Question: Give a one-sentence summary of this figure.
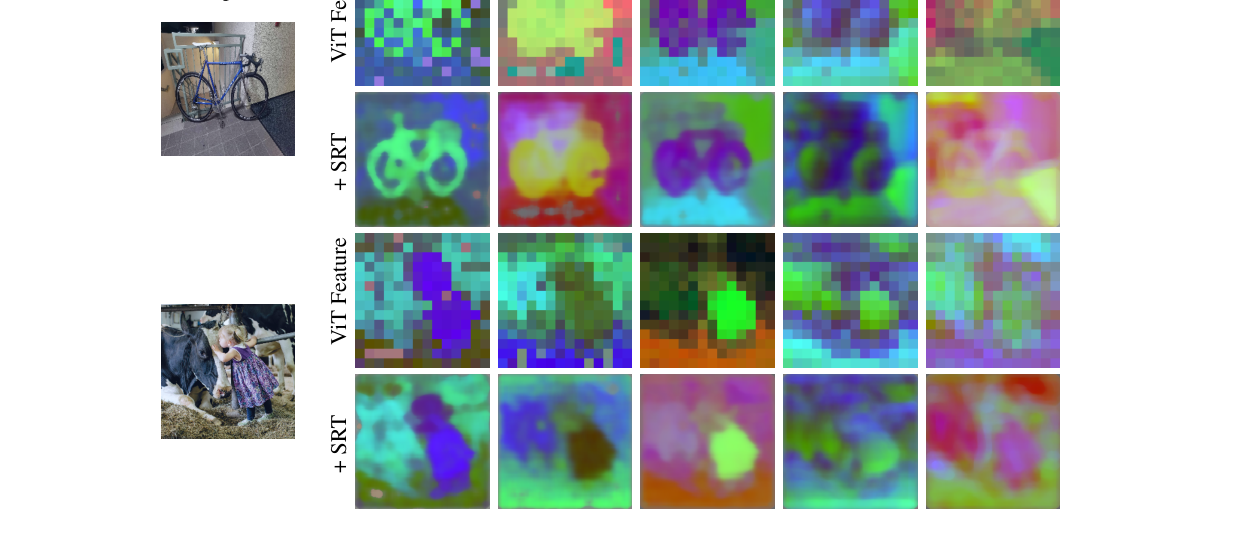
Answer: High-resolution ViT features computed by stochastic resonance. Stochastic Resonance enables enhancing tokenized ViT features during inference without the need for additional training or modifying ViT forward pass. Here we present enhanced features from different pre-trained ViT models, visualized via Principal Component Analysis: CLIP (Radford et al., 2021) captures major image components. Interestingly, although Supervised (Dosovitskiy et al., 2020) and DINO (Caron et al., 2021) are trained by different pipelines and training loss, they prioritize similar regions. This may be due to they are trained on the same dataset and thus capture similar inductive bias. In contrast, SAM (Kirillov et al., 2023) and MAE (He et al., 2022) capture local features over high-level semantics.